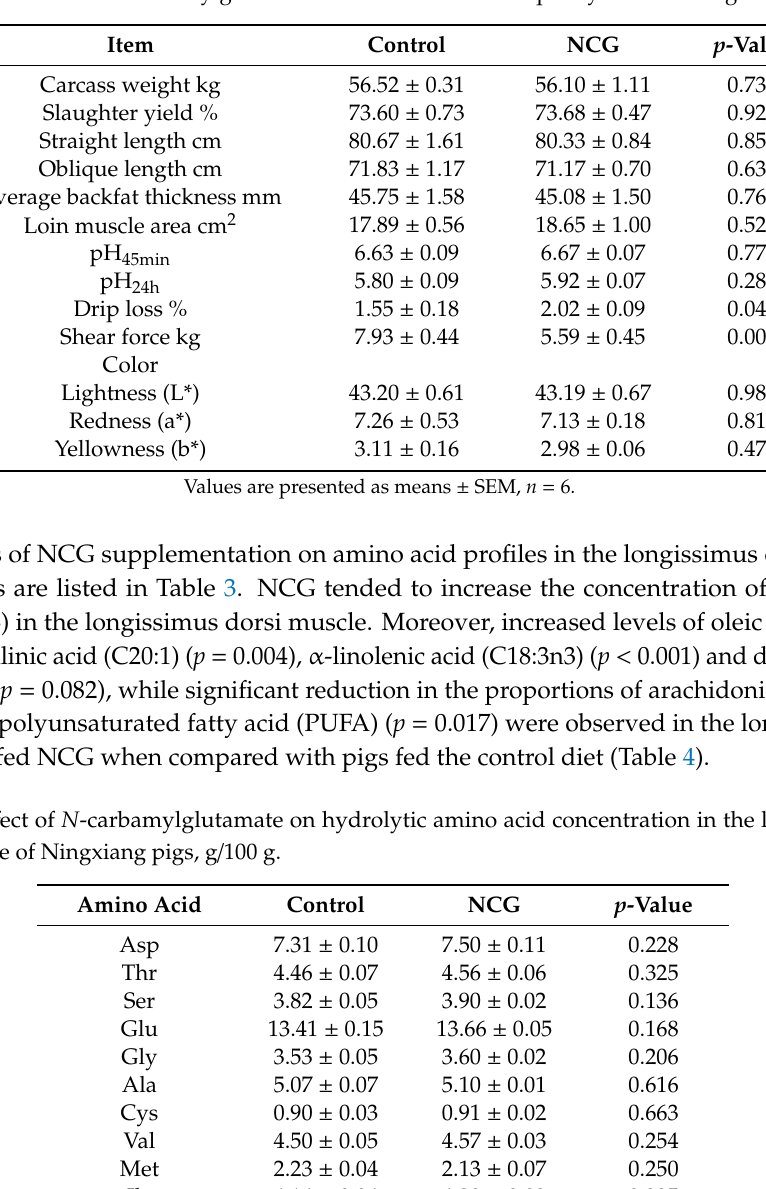
Table 2. E ff ects of N -carbamylglutamate on carcass and meat quality traits in Ningxiang pigs.